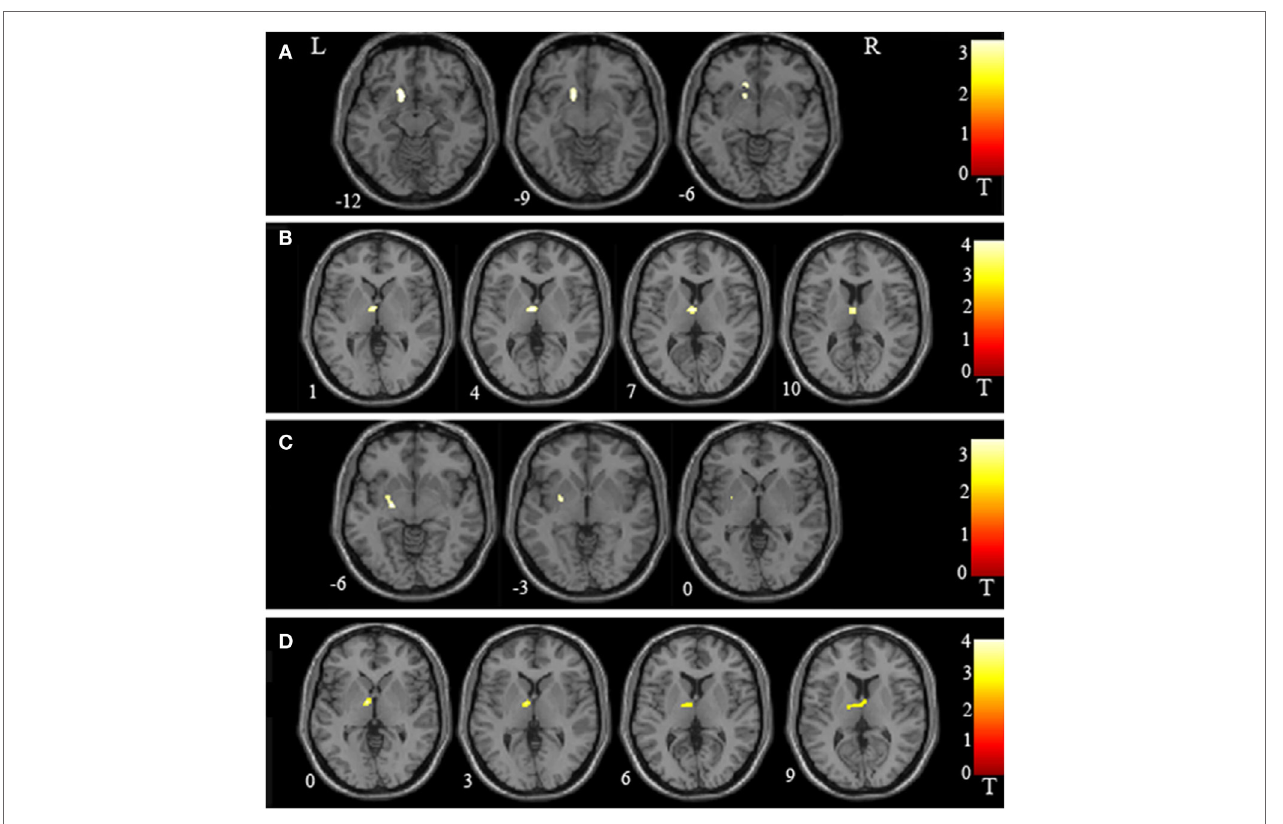
FigUre 2 | Regional volume abnormalities in the putamen and thalamus as identified in inter-group voxel-based morphometry. (a) Schizophrenia patients with delusions (SCHd) had lower regional volume in the left putamen than healthy controls (HC). (B) SCHd had lower regional volume in the left thalamus than HC. (c) SCHd had lower regional volume in the left putamen than schizophrenia patients without delusions (SCHnd). (D) SCHd had lower regional volume in the left thalamus than SCHnd. L, left; R, right. The color bars represent the range of t